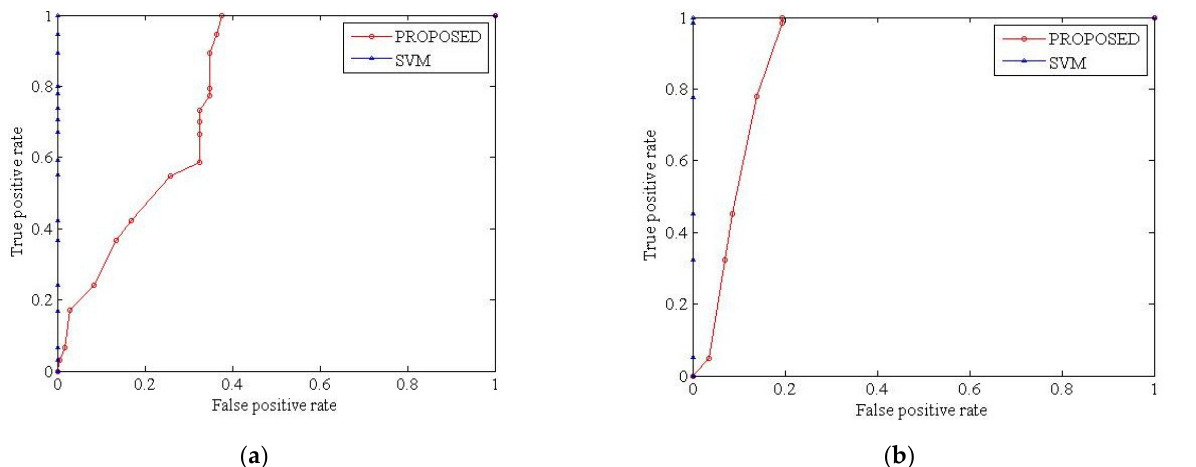
Figure 12. ROC analysis for proposed PCAL for: ( a ) Indian Pines and ( b ) Pavia University dataset.